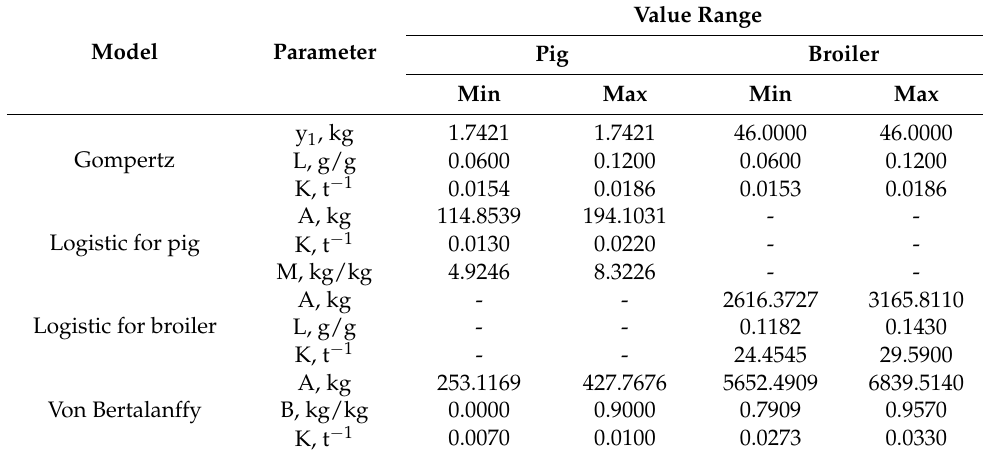
Table 3. Range values of the function parameters for the studied